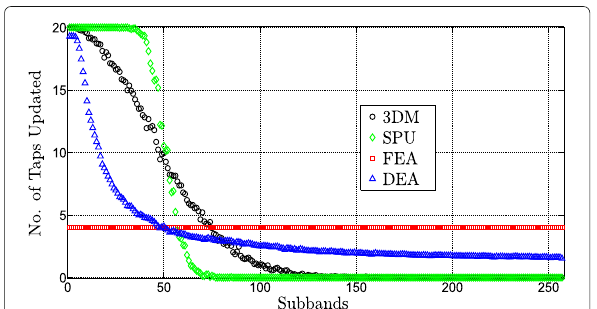
Fig. 7 Number of taps selected in each subband when using the 3DM, SPU, FEA and DEA tap selection schemes for a mono brown noise signal ( Q = 0.2)